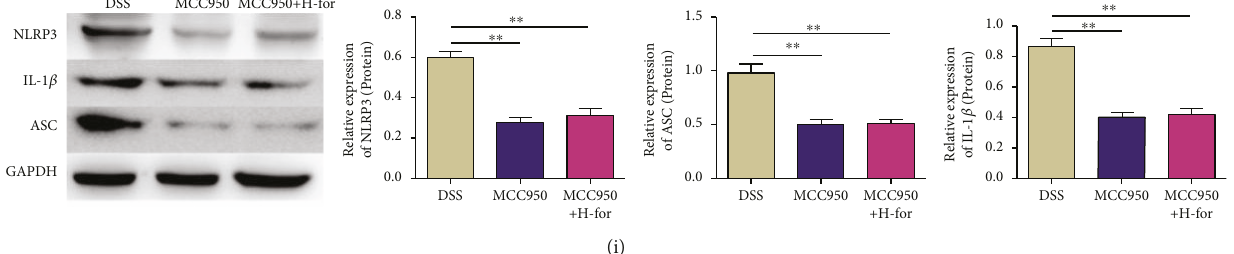
Figure 6: NLRP3 inhibitor MCC950 eliminated the protective e ff ect of H-For on acute colitis in mice. (a) The experimental protocol with For and MCC950 in an acute colitis model. (b) Body weights of mice and (c) disease activity index (DAI) during the disease process. (d) Morphological changes in the mouse colons, (e) variations of colon length of mice, (f) representative HE staining, and (g) histological scores of colonic tissue. (h) Protein levels of claudin-1, occludin, and ZO-1 and (i) NLRP3, ASC, and IL-1 β were analyzed by western blotting. ∗ p < 0 05 , ∗∗ p < 0 01 , ∗∗∗ p < 0 001